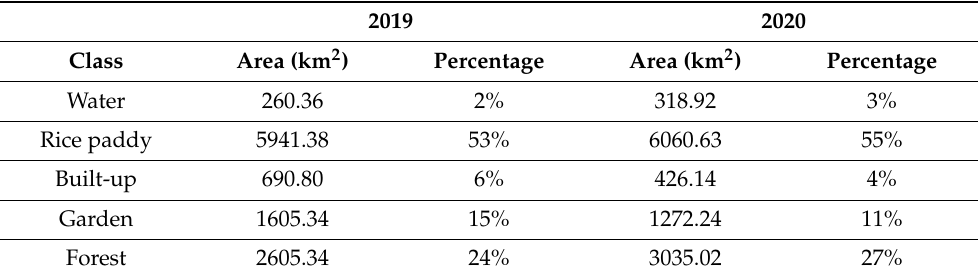
Table 8. Area of land use/land cover before the wet season in 2019 and 2020.